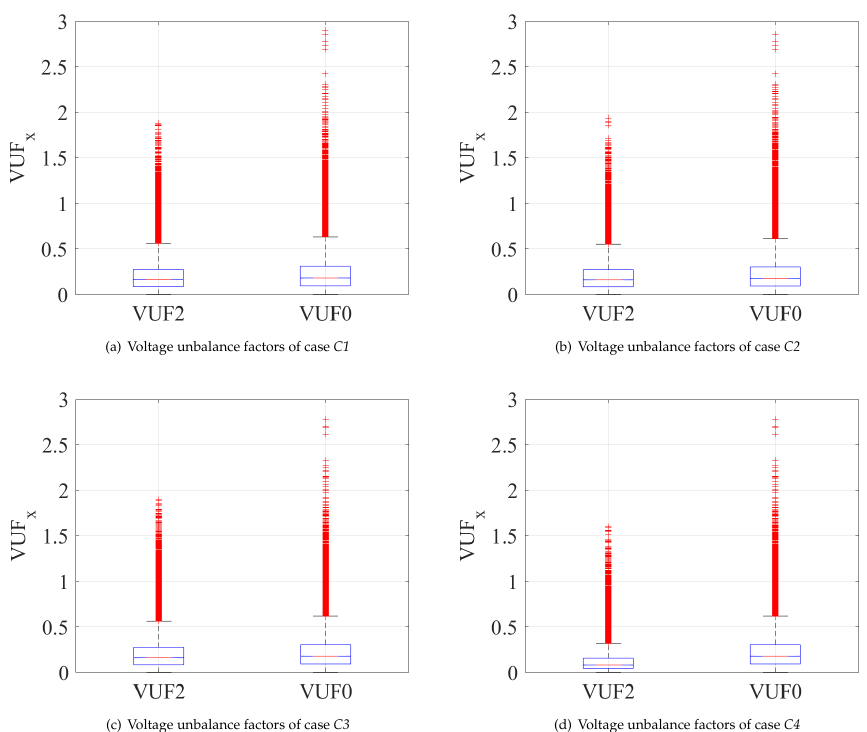
Figure 9. Concatenated VUFs results of the entire LV grid when cases C1 to C4 are examined